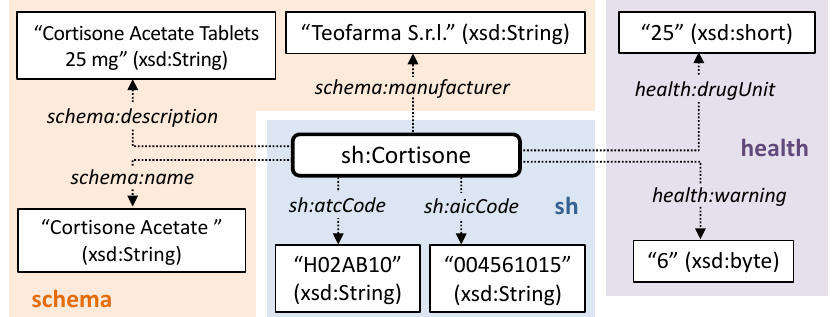
Figure 6. Example of context-aware attributes modeling for